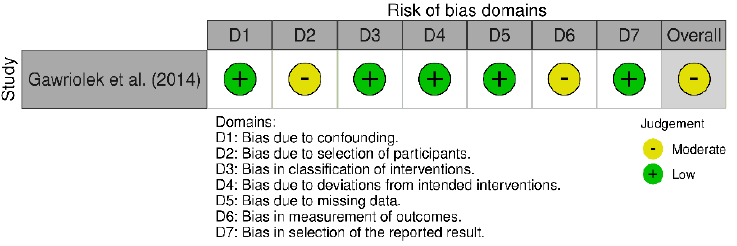
Figure 3. The risk of bias in nonrandomized studies of intervention (ROBINS-I) assessment tool [20].